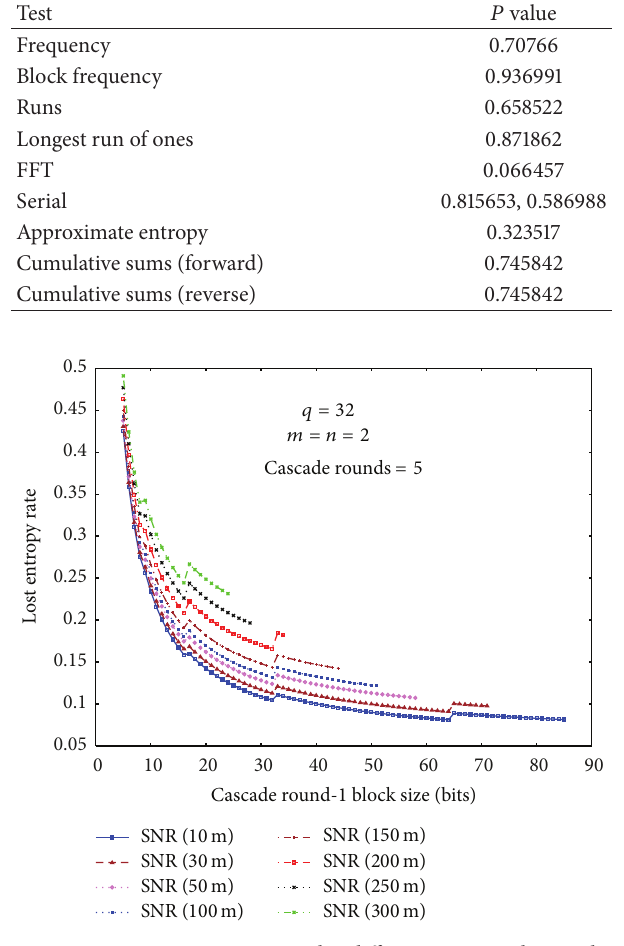
Table 1: NIST statistical test results. To pass each test, the 𝑃 value needs to be greater than 0.01.